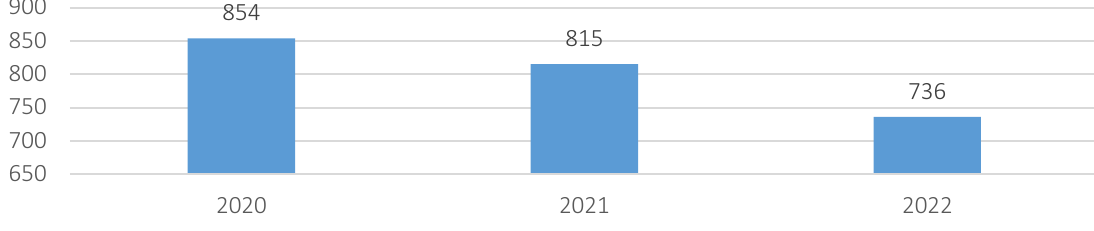
Figure A3. The total number of lecturers at Sumy State University